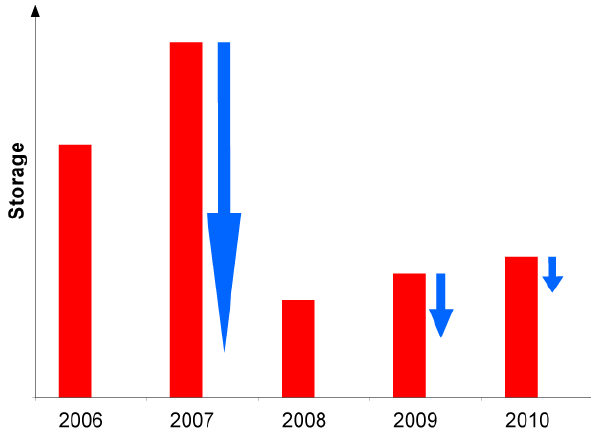
Fig. 9. Hypothetical scheme of subsurface CH 4 storage changes over 5yr. Red rectangles: estimation of storage pool during grow- ing season; their heights on the scheme are proportional to peak emissions in Table 1. Blue arrows: estimation of discharge during autumn burst; arrow sizes correspond to cumulative CH 4 emission documented during post-growing season (Table